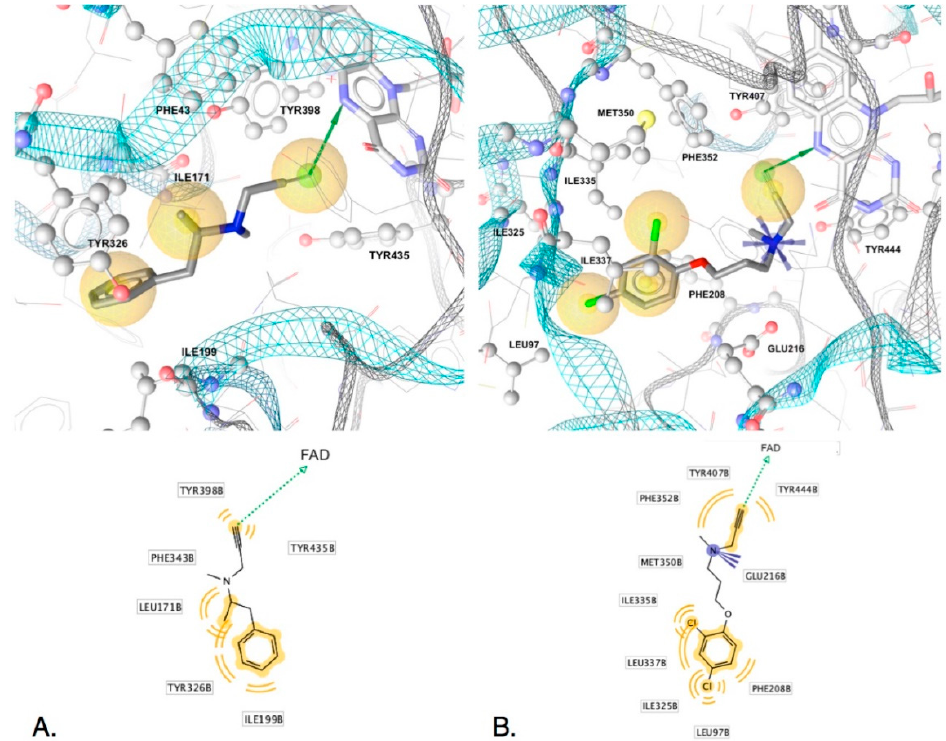
Figure 5. Non-covalent interactions of ( A ) selegiline (L-deprenyl) in MAO-B (PDB ID: 2byb) and ( B ) clorgyline in MAO-A (PDB ID: 2xbr) associated with reversible binding before transformation. Top images show 3D-interactions in binding sites and lower ones display 2D-depictions of ligands with features and interaction partners. Hydrogen atoms are not shown. Hydrophobics (yellow spheres), H-bond donors (green arrows), positive ionizable (blue star). Interactions derived using LigandScout 4.4.